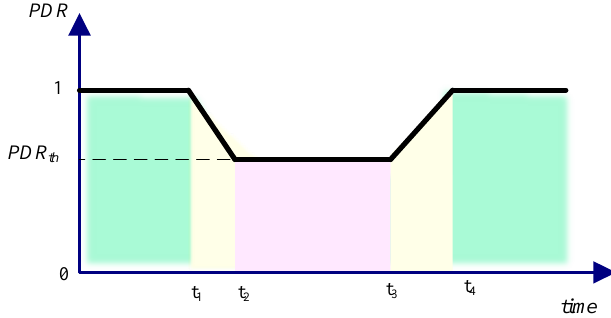
Figure 7. Resiliency curve of the SCN model for Case-III .